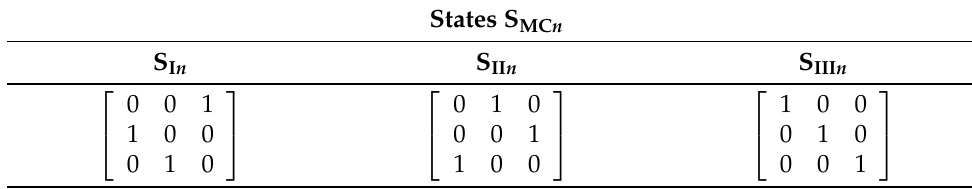
Table 4. Allowed S MC n switch